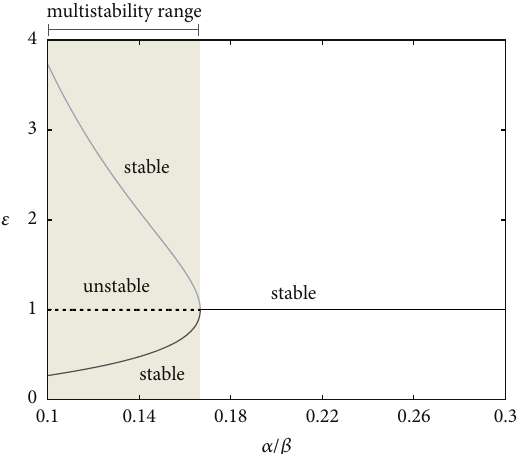
Figure 5: Example 2: positive solutions of system (62) as a function of the parameter ratio 𝛼/𝛽 .